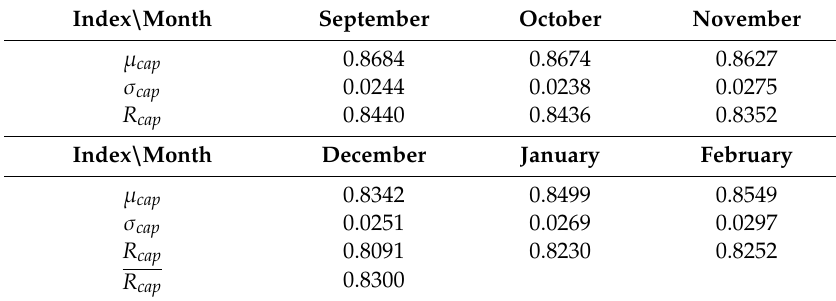
Table 7. The capacity reliability of the air traffic network (CARN) of the US air traffic network.